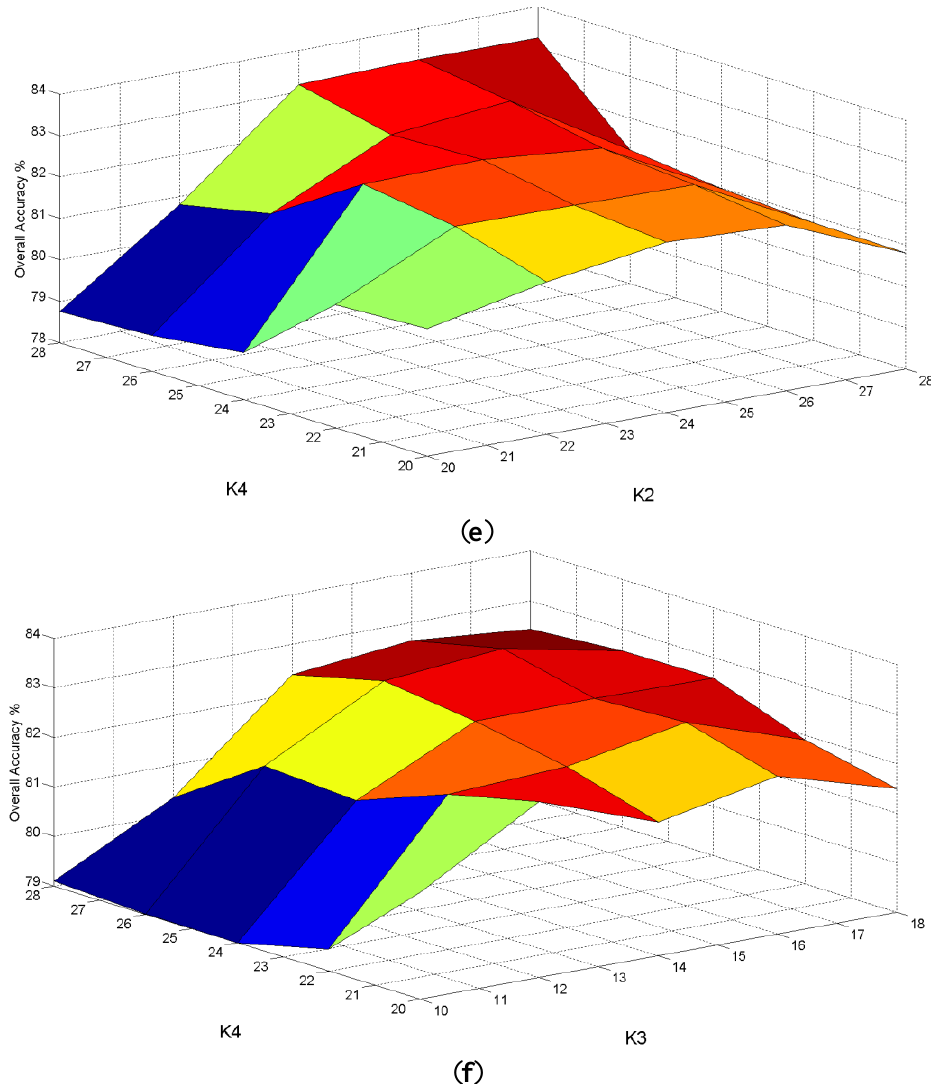
Figure 10. The sensitivity analysis of four